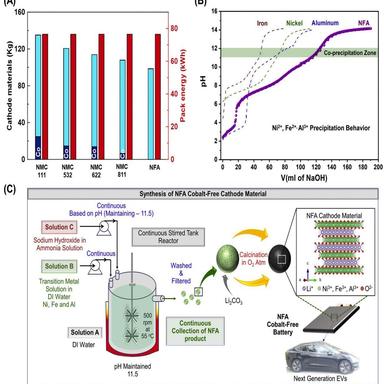
(A) BatPaC estimation of cobalt amounts in various conventional cathode materials when compared to NFA class of cathodes for 1 EV with a range of 260 miles, (B) Precipitation behavior of nickel, iron and aluminum when compared to co-precipitation behavior of NFA, (C) Schematic representation of the synthesis and development route employed for the NFA class of cathodes.